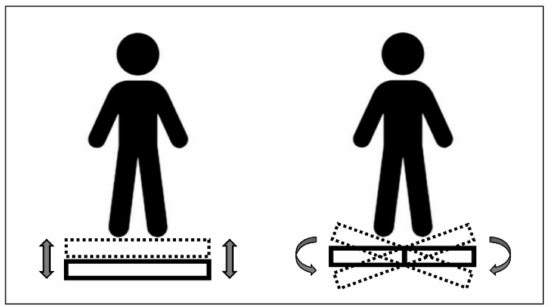
Figure 1. Vertical ( left ) versus side-alternating ( right ) vibrations in standing